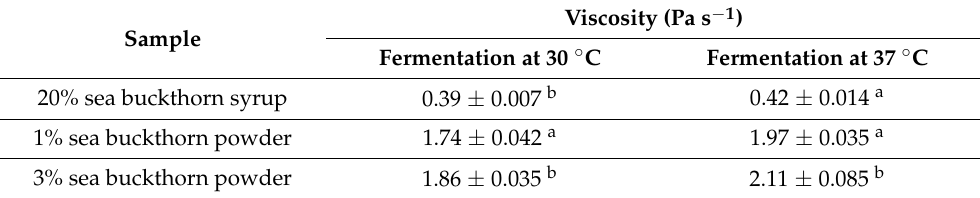
Figure 3. Variations in titratable acidity of beverages during fermentation. ( a ) Samples with SBS; ( b ) Samples with SBP. Table 2. Rheological parameters of taste